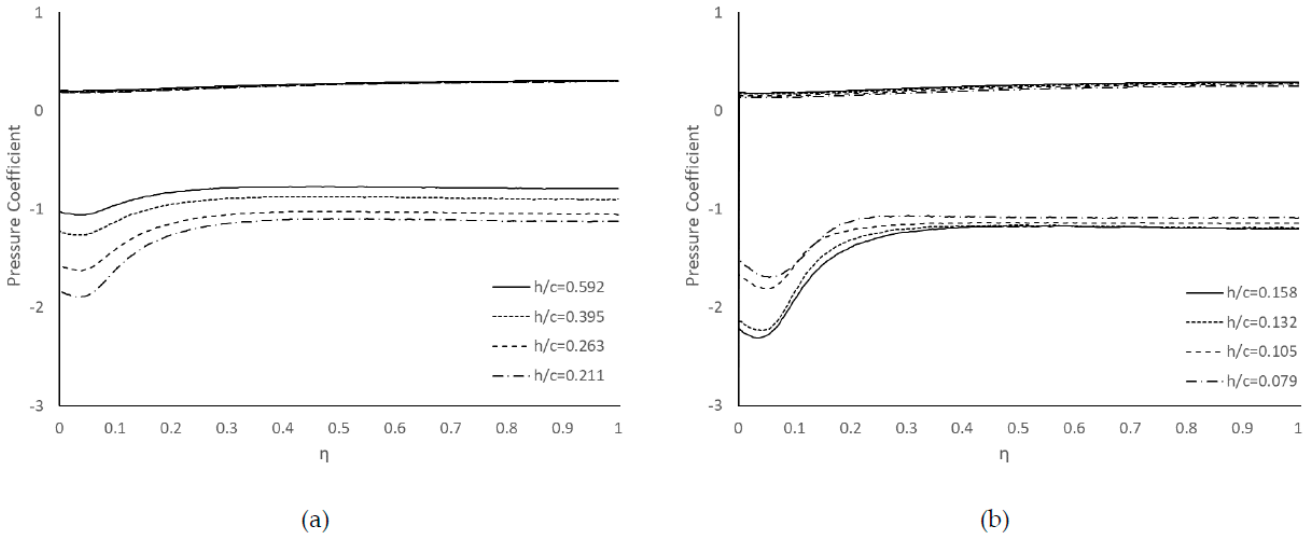
Figure 10. Spanwise surface pressure on flap: ( a ) large heights, ( b ) small heights.